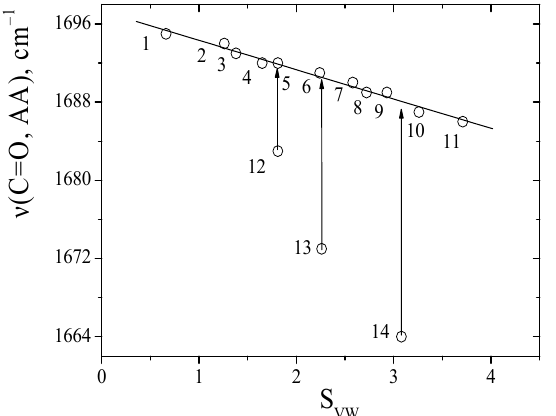
Figure 4. A comparison absorption frequencies of the C=O groups between alanine anhydride and the S VW parameter, values correspond to the data in Table 1.